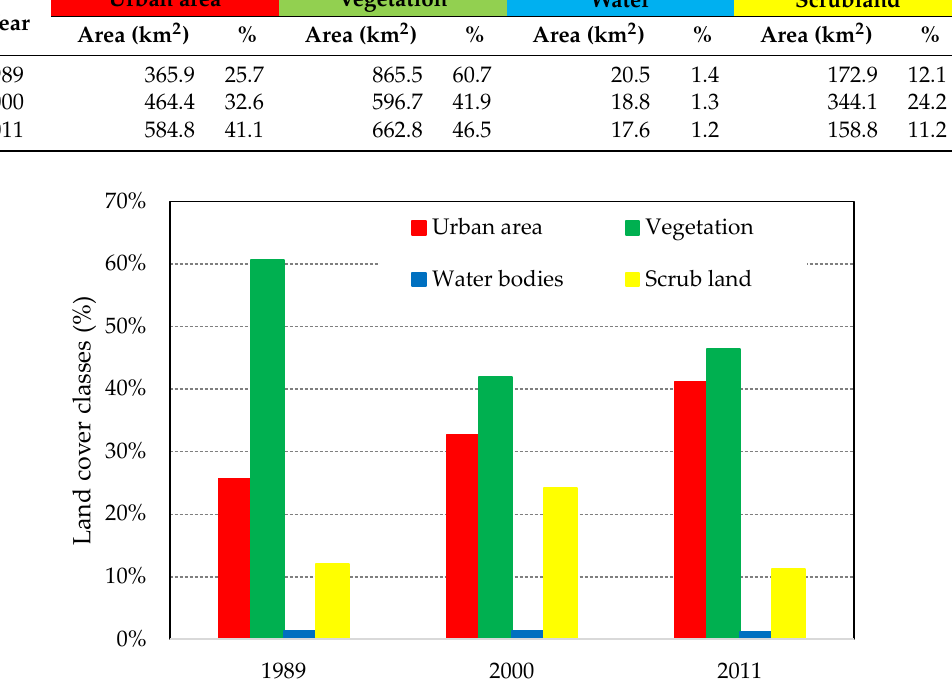
Figure 7. Changing pattern of LULC classes in the study area from 1989 to 2011.